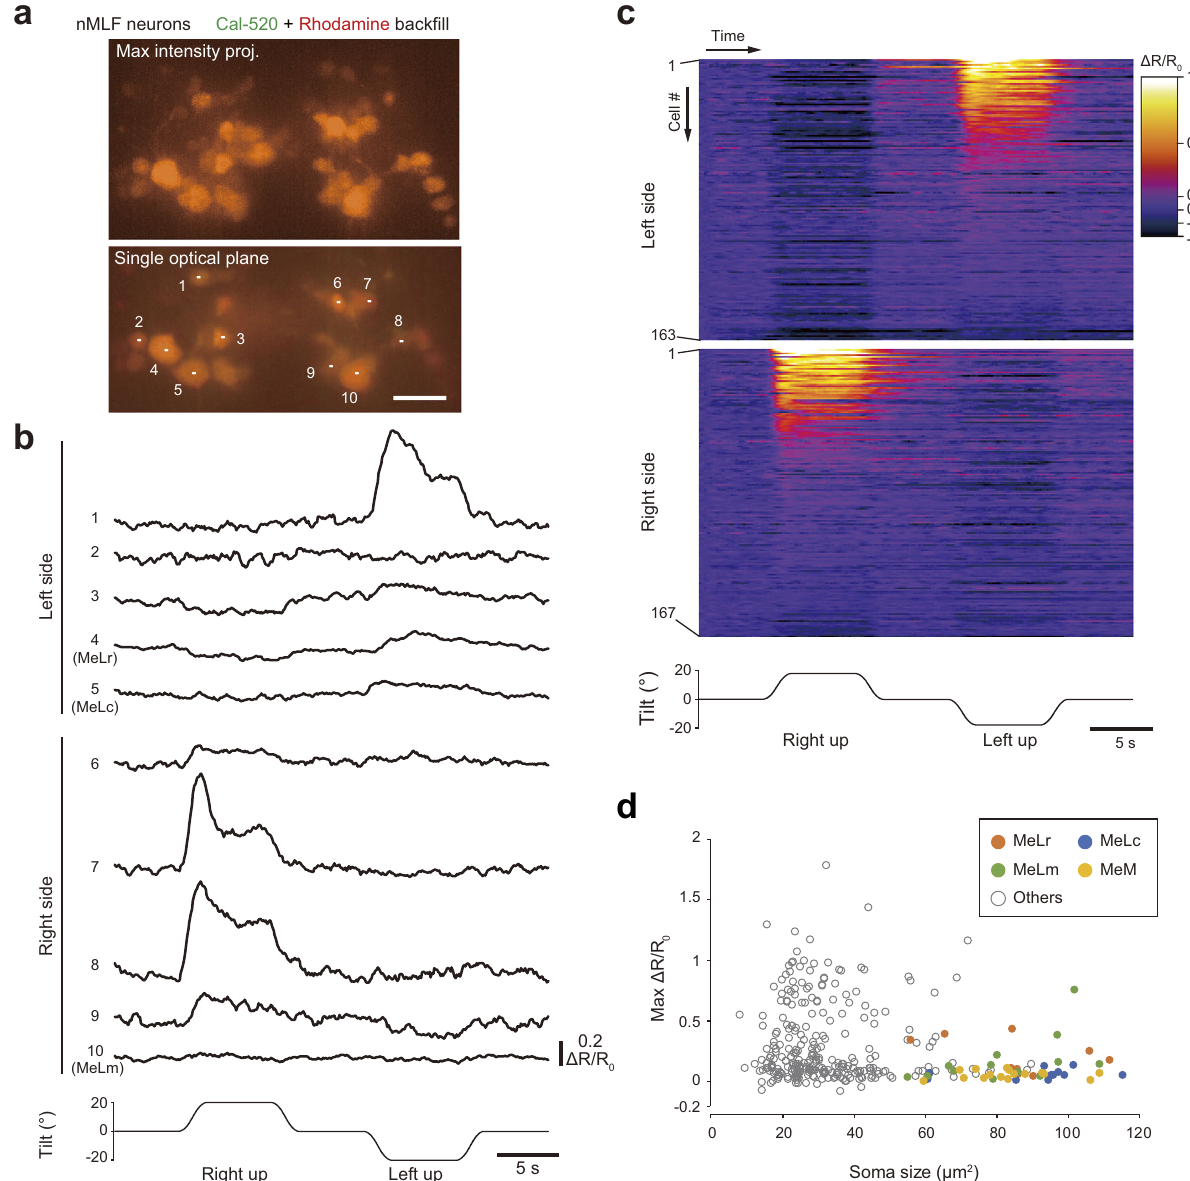
fi sh, with 163 for the left side and 167 for the right side) in response to a roll tilt. Neurons are grouped by their location (left or right) and are sorted by the max- imum Δ R/R 0 during ipsi-up tilt. Neuronal indexes are denoted on the left. d Graph showing the maximum Δ R/R 0 during ipsi-up tilt ( Y axis) vs. the soma area size ( X axis). Source data are provided as a Source Data fi